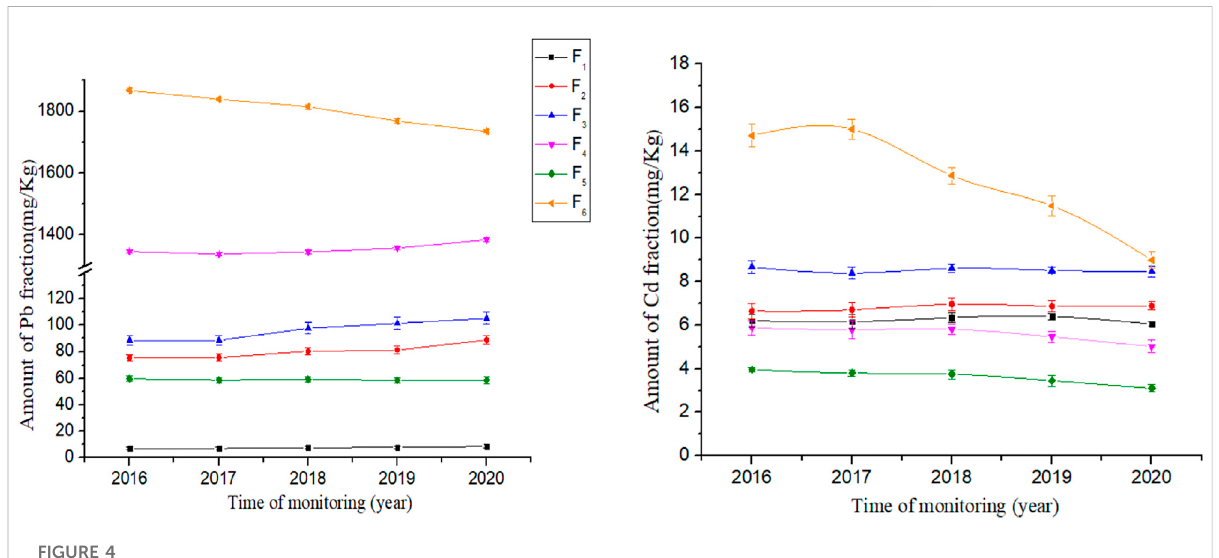
FIGURE 4 Distribution (F 1 ~F 6 ) changes of Pb and Cd in fi ve monitoring